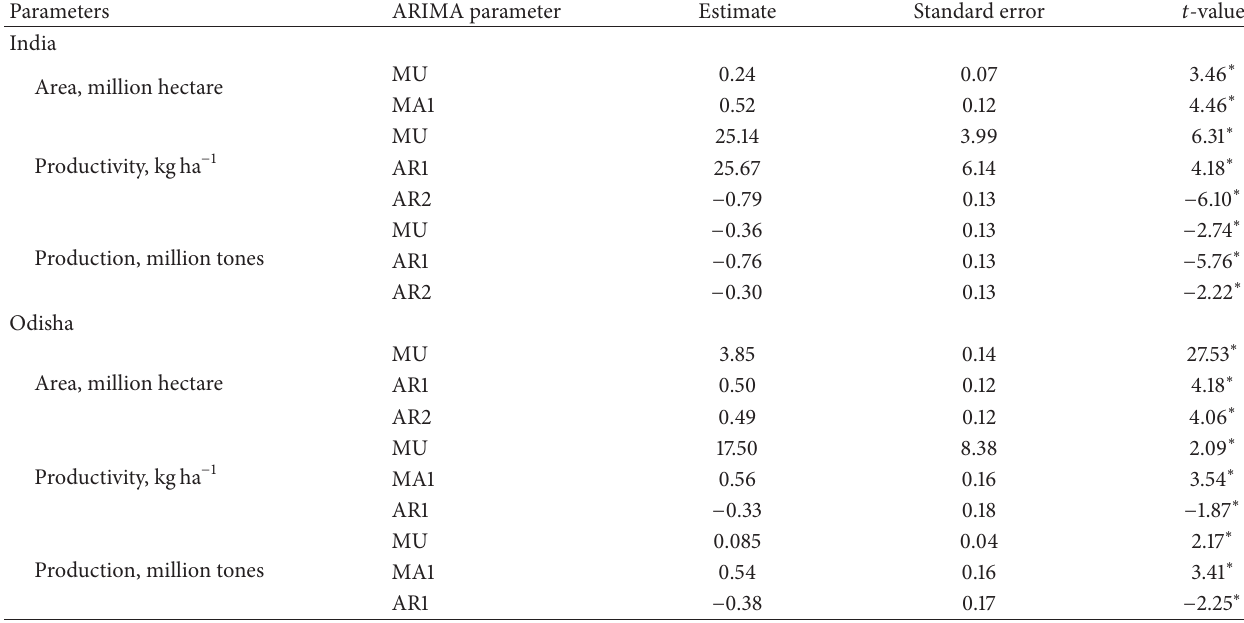
Table 3: Final estimates of parameters of autoregressive integrated moving average (ARIMA) models fitted for time series data on rice area, productivity, and production for Odisha and